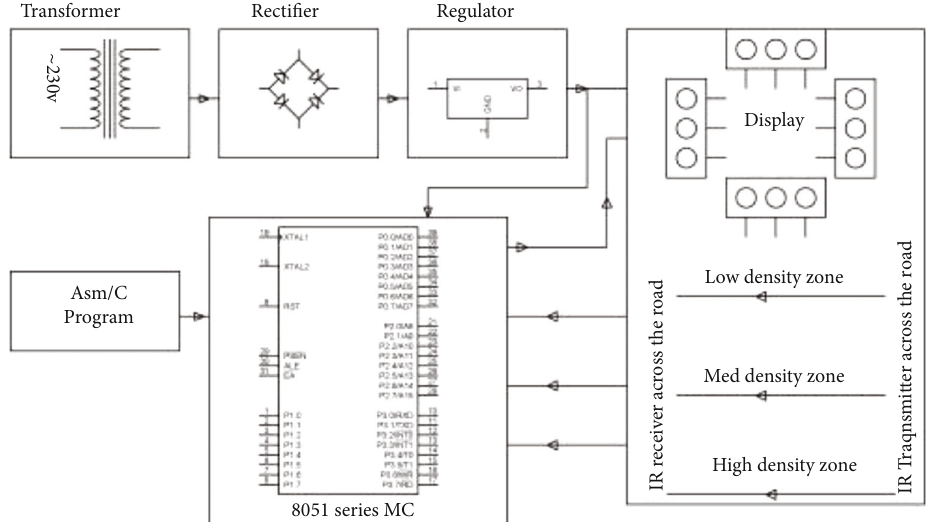
Figure 3: The circuit diagram for the detection of the tra ffi c indications.